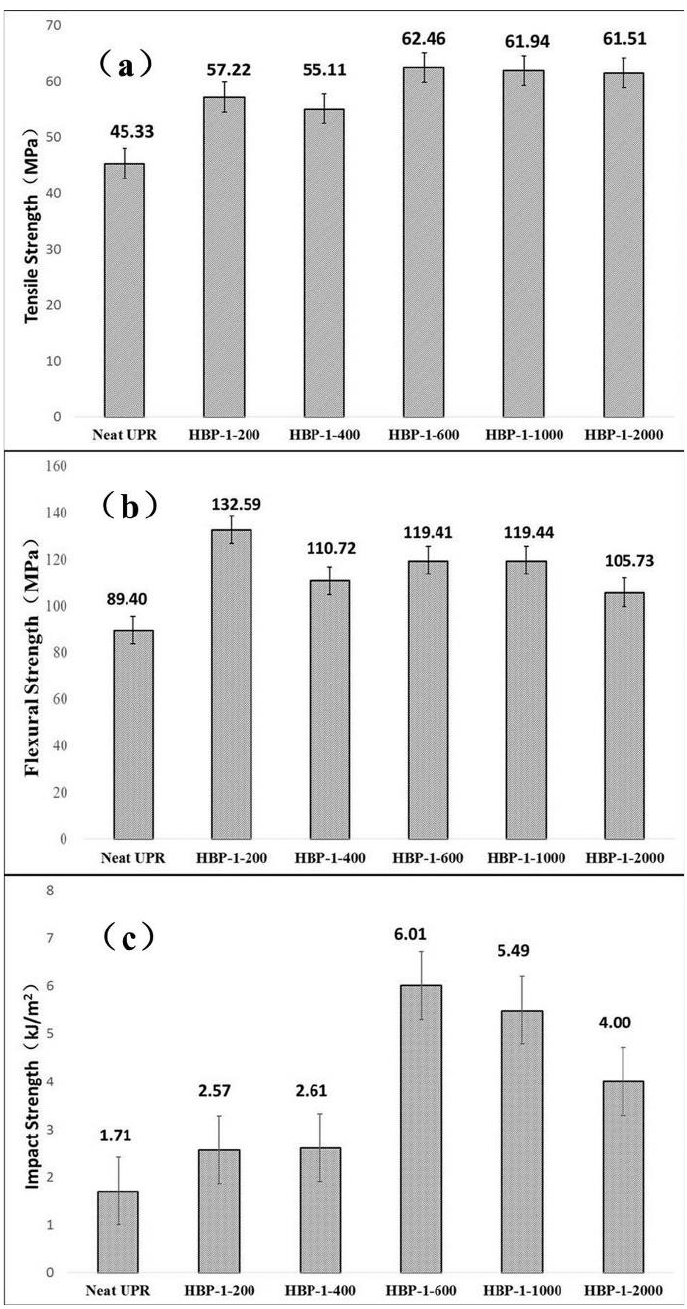
Figure 6. The effect of HBP-1 on mechanical properties of UPR: ( a ) tensile strength; ( b ) flexural strength; ( c ) impact strength.